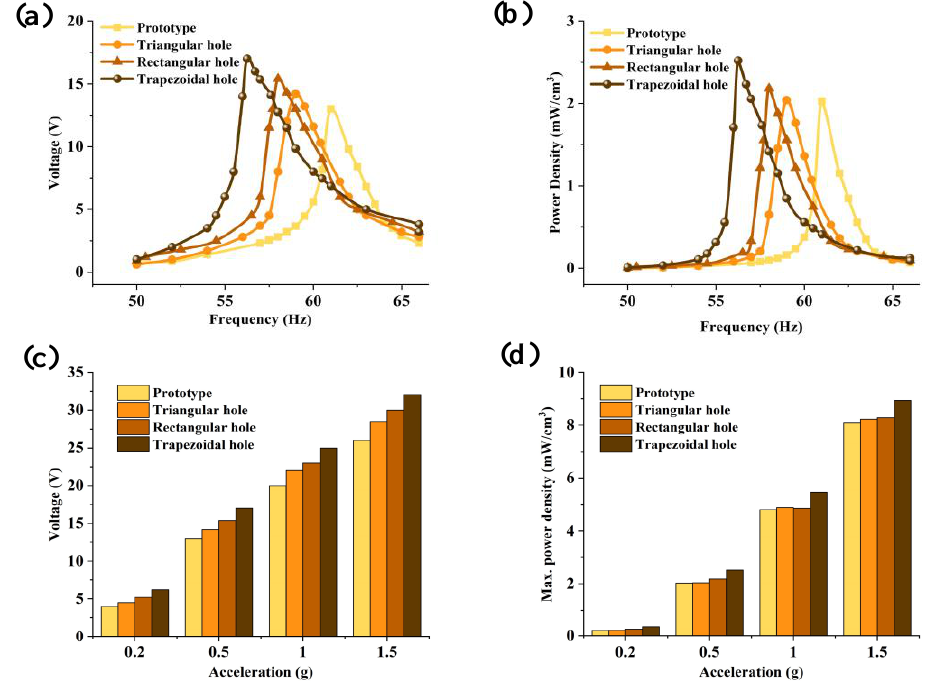
Figure 8. Output performance of various types of piezoelectric energy harvesters. ( a ) Voltage output of various devices at different frequencies. ( b ) Power density of various devices at different frequencies. ( c ) Maximum peak voltage of various devices at different accelerations. ( d ) Maximum power density of various devices at different accelerations. Table 3. Comparison of the performance of various types of harvesters.